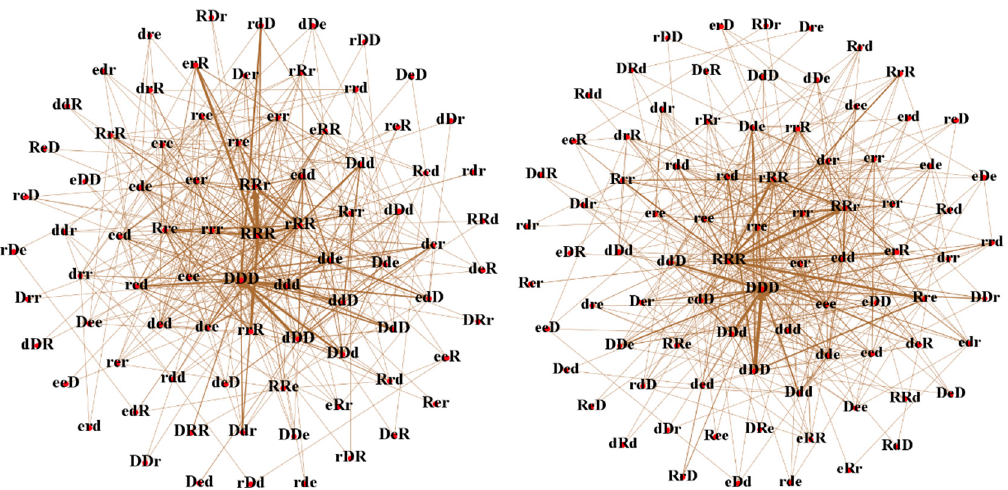
Figure 7. The hydrological network constructed from the water level over the two periods. (The graph on the left is the network of the early period. The graph on the right is the network of the latter period). Here, the number of rapid rising patterns, slow variation patterns and rapid declining patterns were counted for the two periods (Table 2), where the rapid rising pattern meant that the three meta patterns consisted of R and r only, the slow variation pattern consisted of e only, and the rapid declining pattern consisted of d and D only. Table 2. The statistical results of three patterns during the two